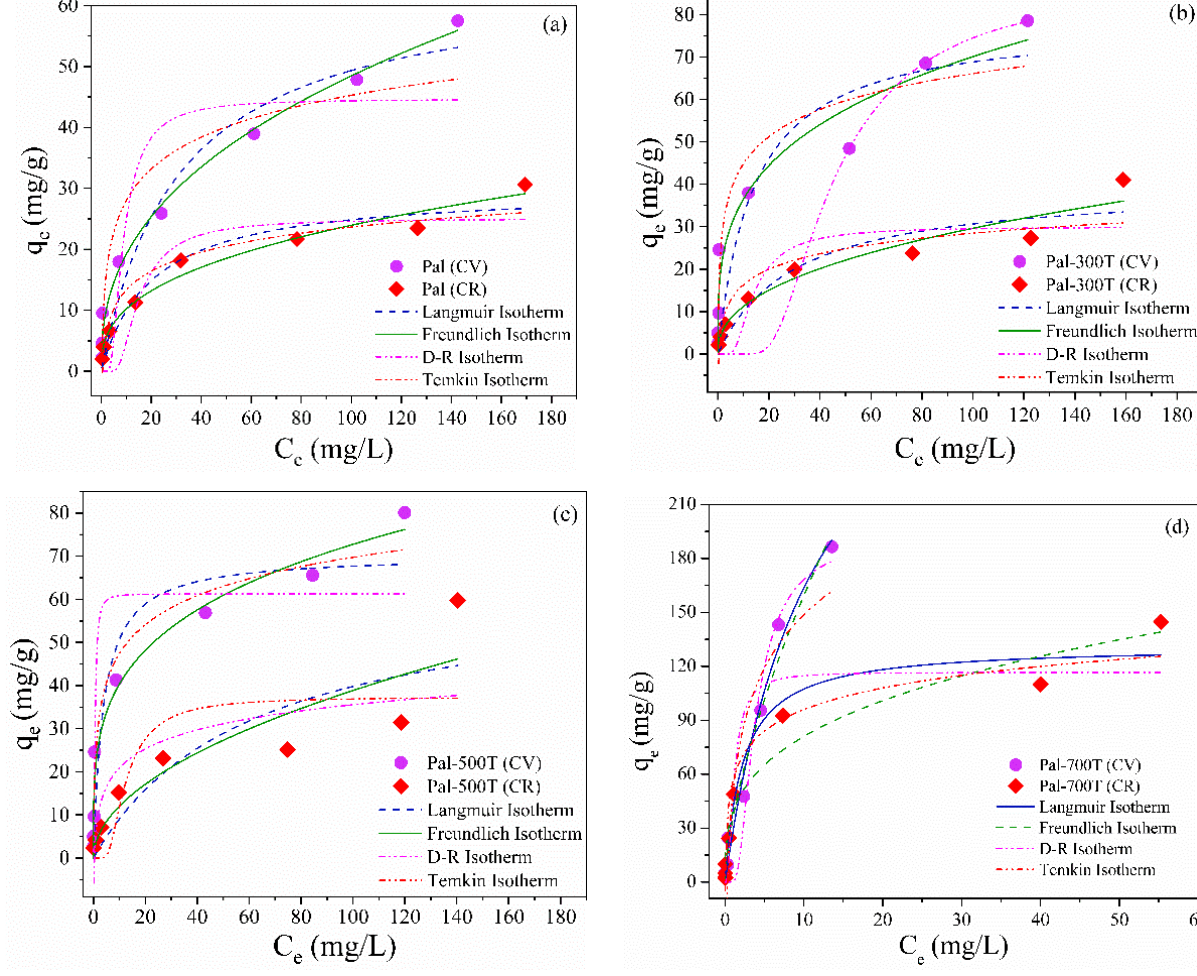
Figure 4. Nonlinear adsorption isotherms (Langmuir, Freundlich, D-R and Temkin) of CV and CR for ( a ) Pal, ( b ) Pal-300T, ( c ) Pal-500T and ( d ) Pal-700T. Table 3. Langmuir, Freundlich, D-R and Temkin isothermal parameters for CV and CR adsorption.